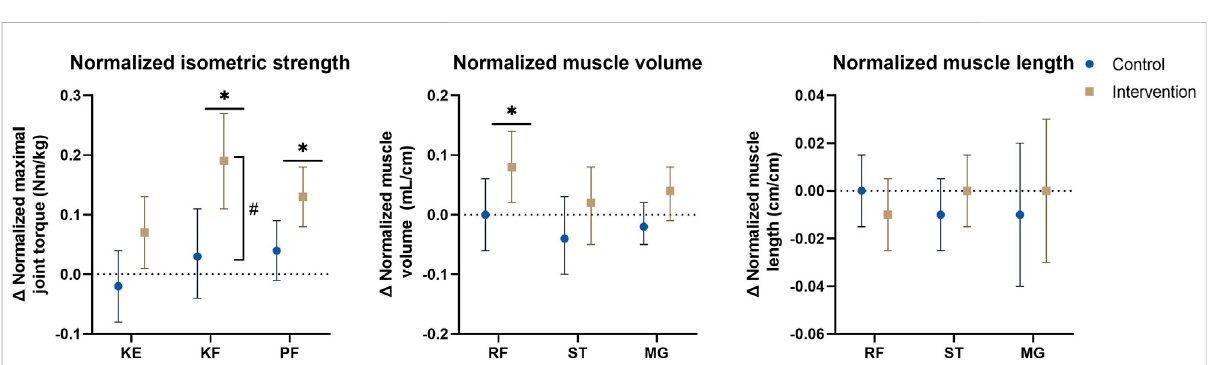
FIGURE 4 Estimated marginal mean differences with 95% con fi dence interval of mixed model analyses for normalized muscle morphology and isometric strengthparameterswithresultsforwithinandbetweenanalysesincludingallparticipantsandallaffectedlegs.#:signi fi canttime*groupinteraction- effectat p ≤ 0.01.*:signi fi cant time-effectat p ≤ 0.01.Abbreviations: Δ ,change;KE,kneeextension;KF,knee fl exion;MG,medial gastrocnemius; PF, plantar fl exion; RF, rectus femoris; ST, semitendinosus. Units: Cm/cm, centimeter/centimeter; mL/cm, milliliter per centimeter; Nm/kg, Newton-meter per